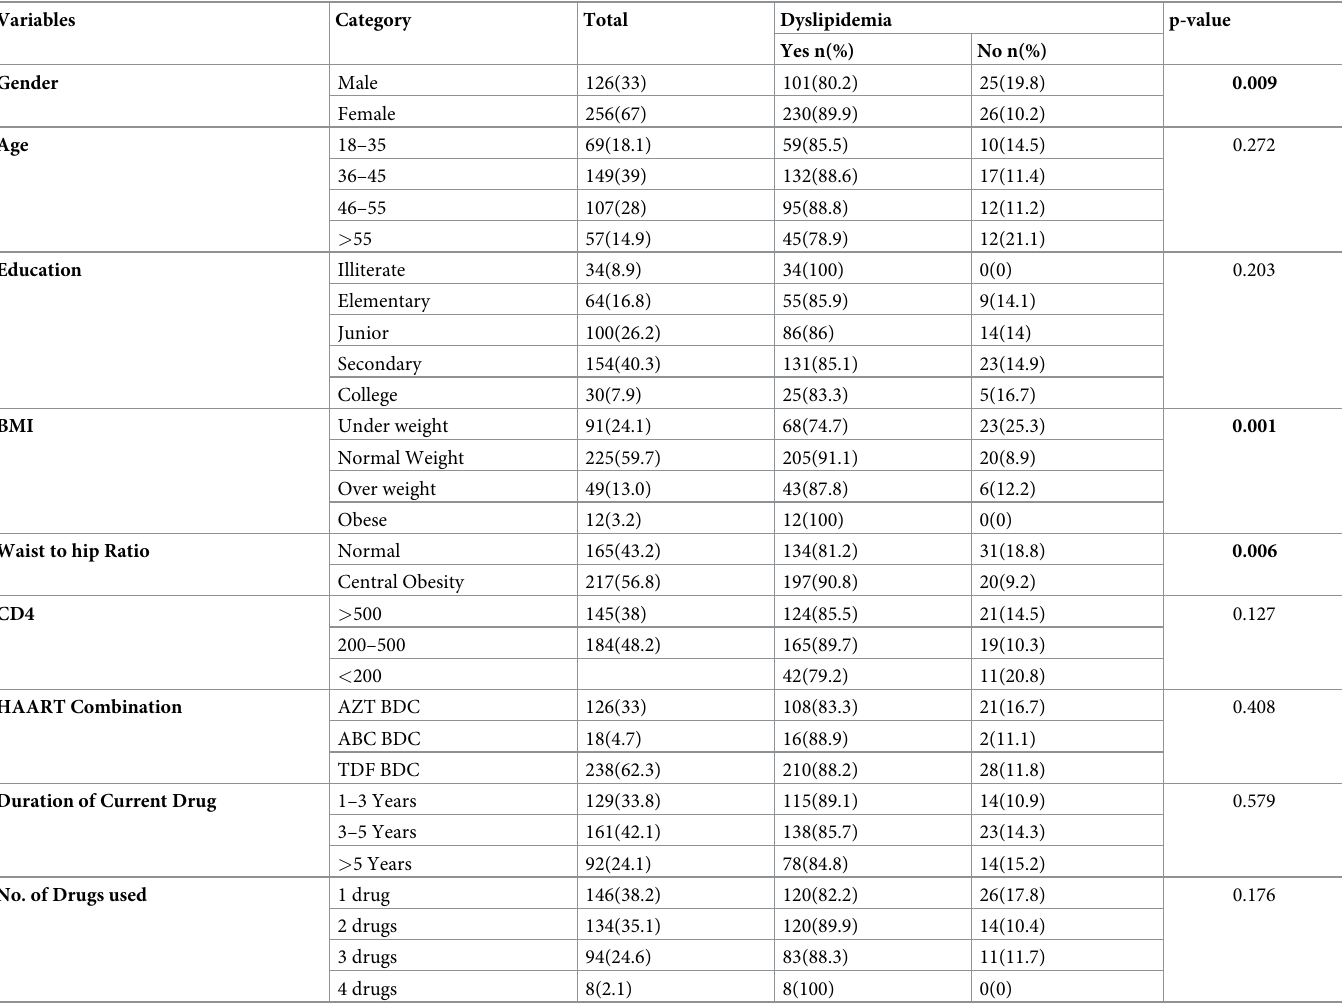
Table 1. Prevalence of dyslipidemia in HIV infected patients in Asmara, Eritrea.